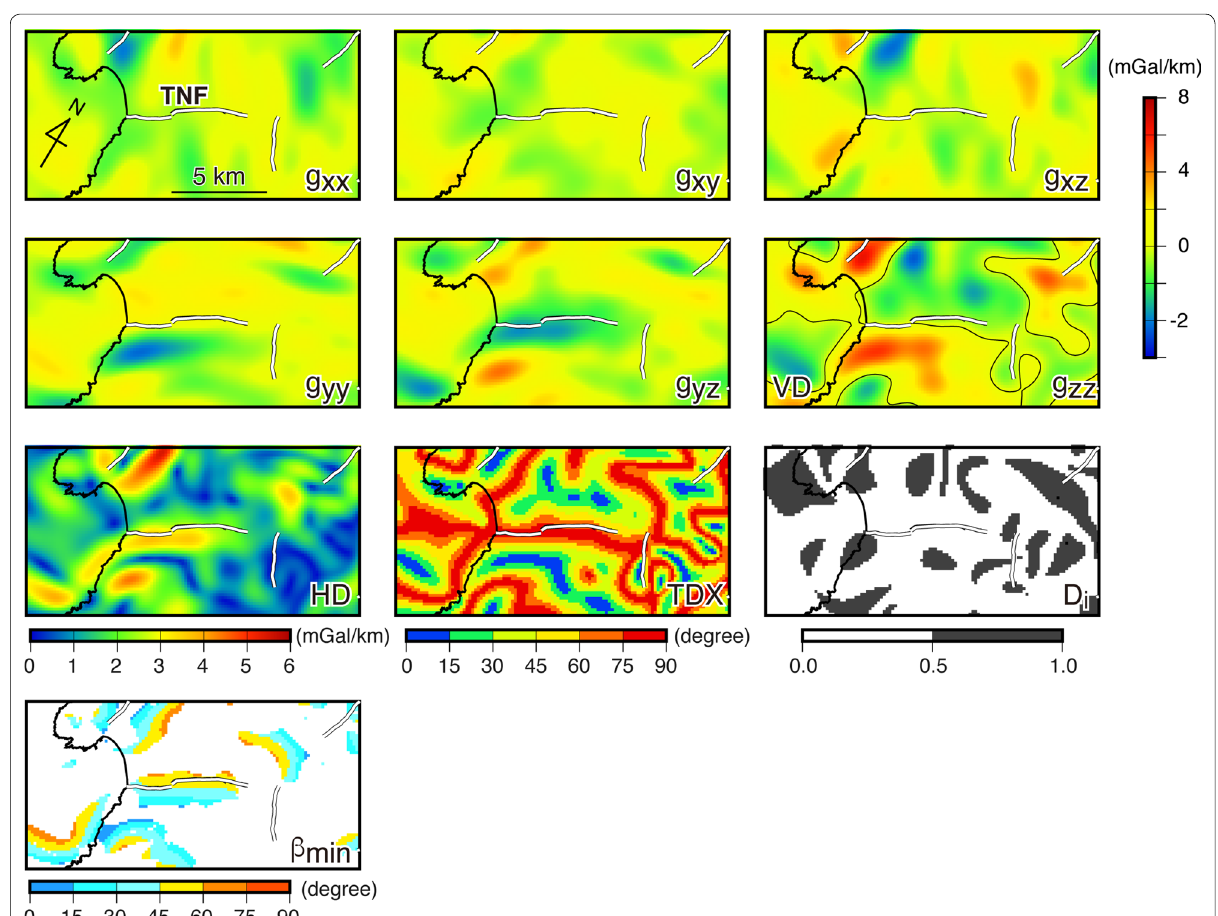
Fig. 4 Maps of the six components of gravity gradient tensor and indices (HD, VD, TDX, D i , β min ) calculated from gravity gradient tensor components. White lines are active faults. Black lines in the VD ( g zz ) panel represent the zero isoline of VD. White and dark gray areas, respectively, in the D i panel indicate that whether the subsurface structure is approximately two-dimensional or three-dimensional. β min shows the dip angle of the subsurface